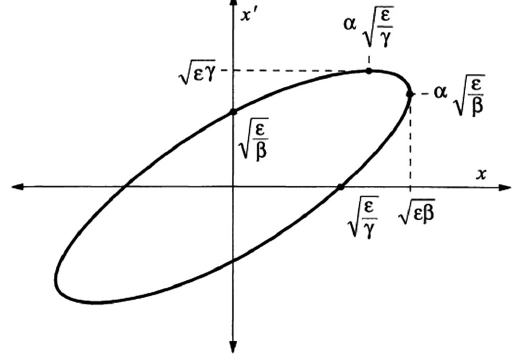
FIG. 2. The phase ellipse of particles in the transverse x − x 0 phase space